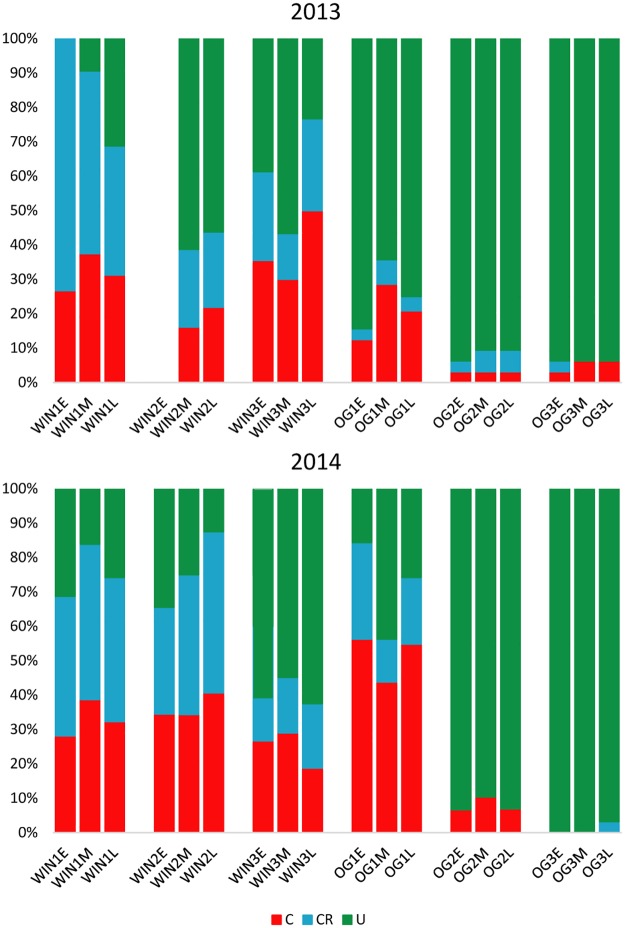
MLG type frequency charts for 2013 and 2014 winery and OG vineyard fermentations.Columns labeled WIN represent winery fermentations; columns labeled OG represent OG vineyard fermentations. Each 3-column cluster represents a single fermentation out of triplicate fermentations (numbered 1, 2, 3). The colors in each column [red, commercial (C); blue, commercial-related (CR); green, unique (U)] represent the frequencies of MLG types at a fermentation stage (E, early; M, mid; L, late). The early timepoint of the second winery replicate in 2013 was omitted as <10 isolates were collected.